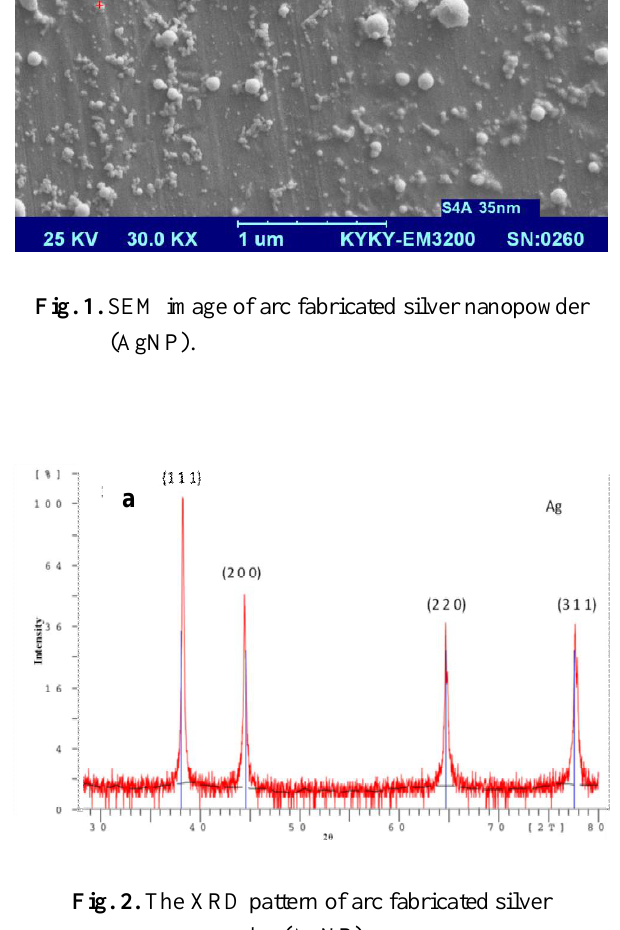
Fig. 2. The XRD pattern of arc fabricated silver nanopowder (AgNP).